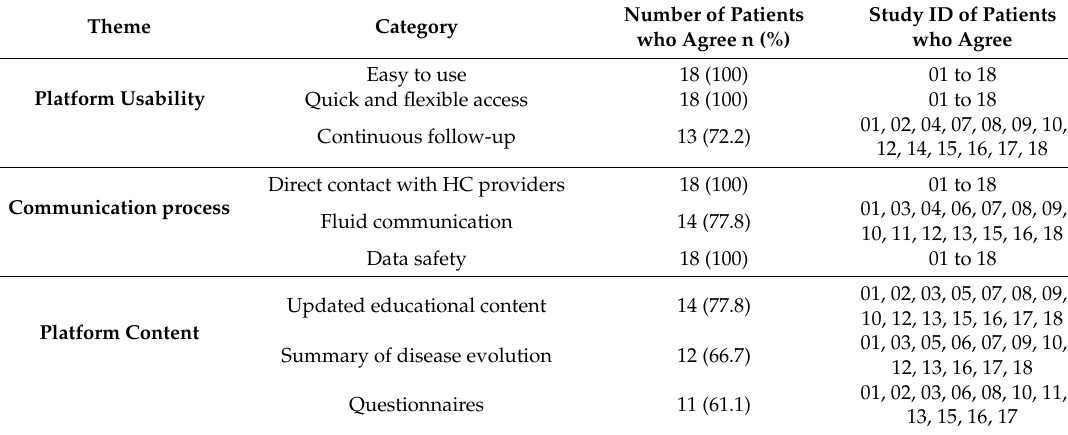
Table 2. Agreement of patients with the themes and categories that emerged.